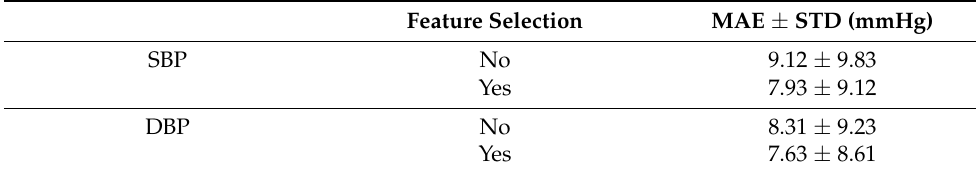
Table 3. Results before and after feature selection.